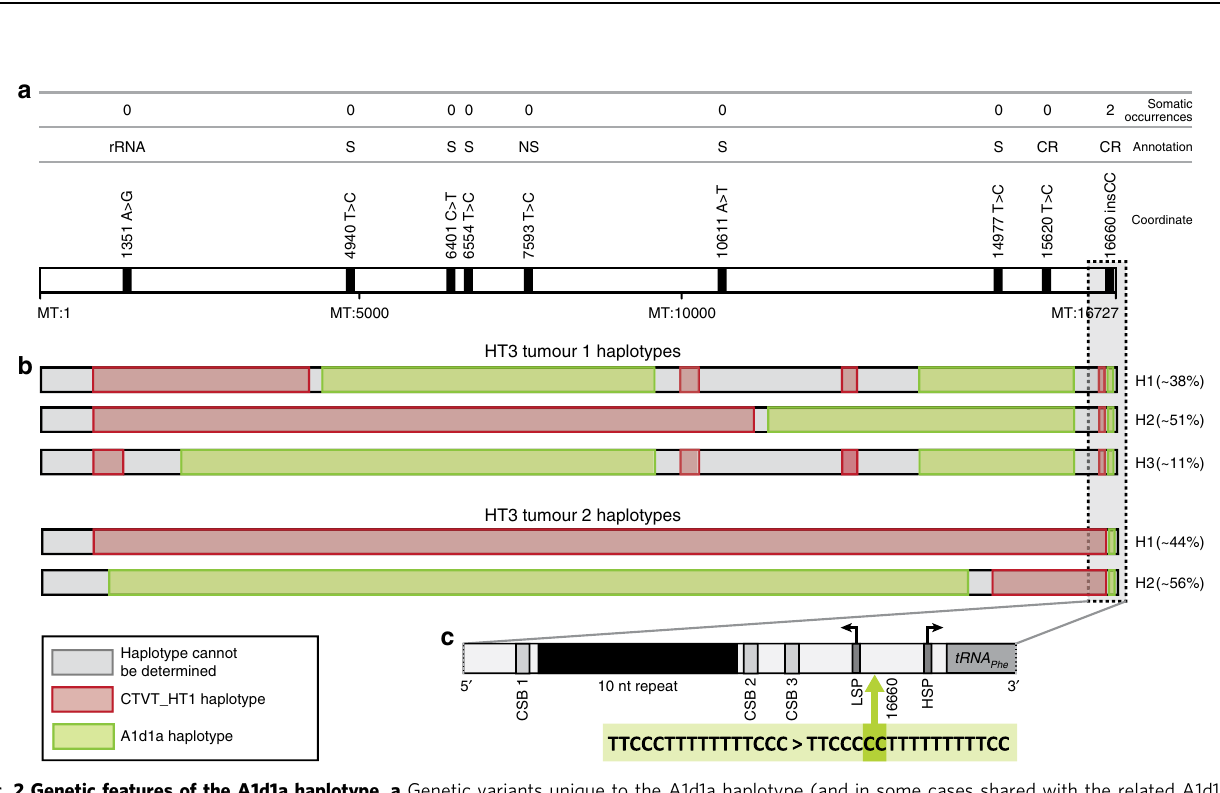
Donor haplotype group, incumbent CTVT haplotype that was replaced, number of tumours observed within each horizontal transfer group, percentage heteroplasmy (the fraction of mtDNAs in the tumour derived from the incoming haplotype) and geographical locations in which tumours were observed are listed for each HT event. The two tumours derived from HT3 each carried a heteroplasmic mixture of recombinant haplotypes from the incumbent and incoming mtDNAs.